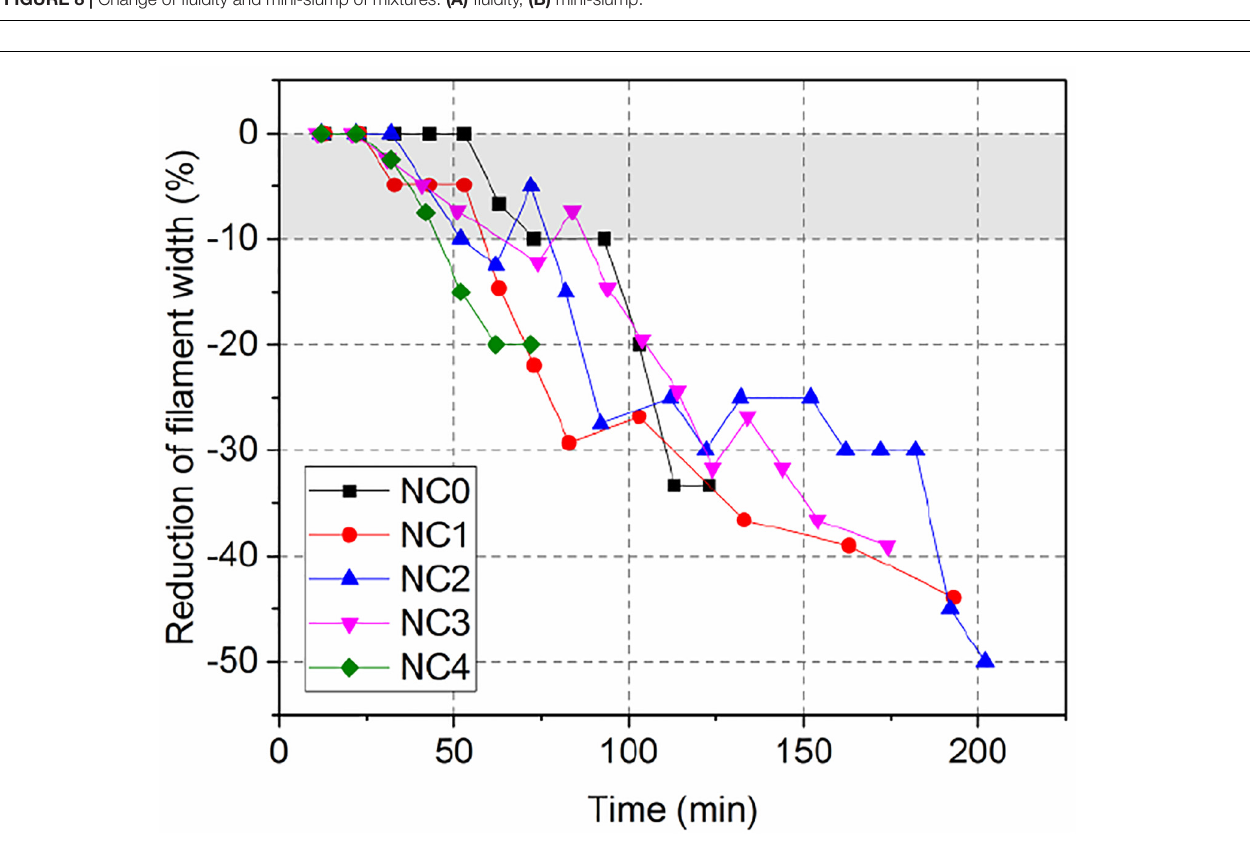
FIGURE 9 | Reduction of filament